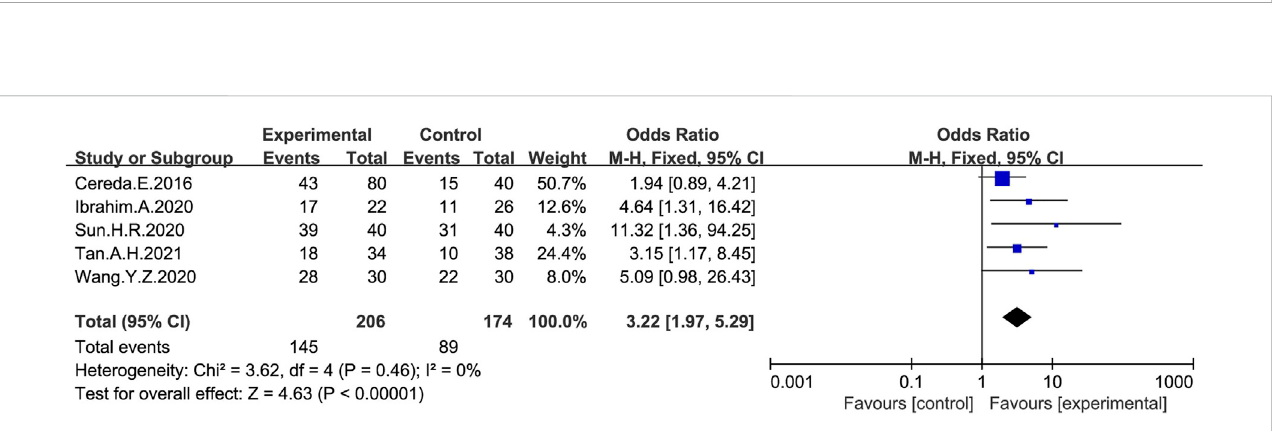
FIGURE 4 Forest plot of Stool frequency in the probiotic intervention group versus that of the control group. Fixed-effects models were used to analyze OR and 95%